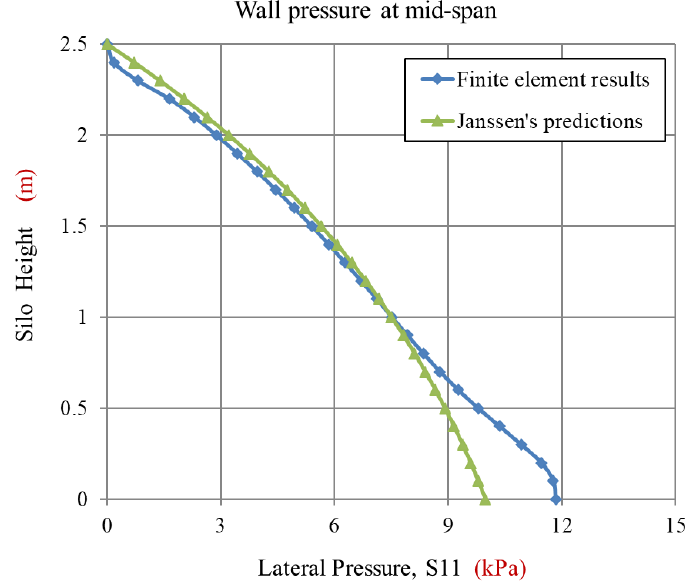
Figure 10. Finite element results and Janssen predictions along the silo height in case of the rigid walled silo.